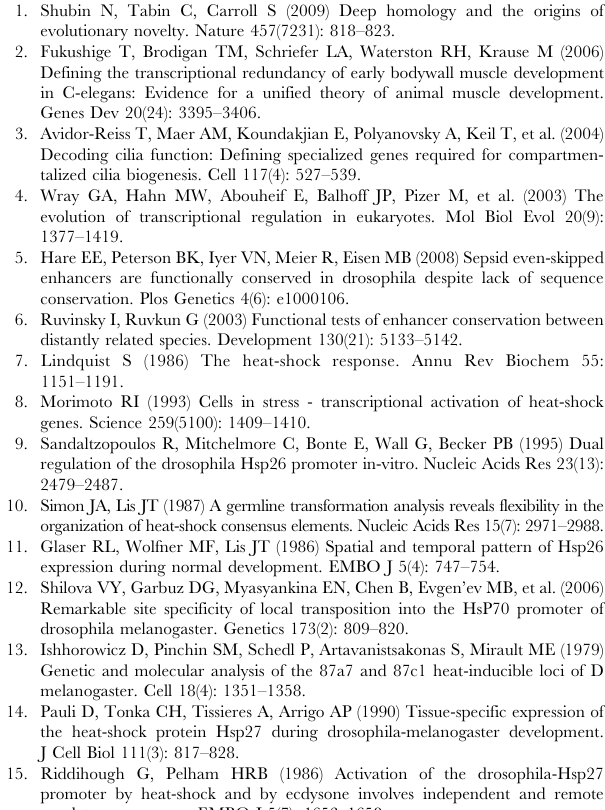
Figure S1 Expression pattern in C. elegans of the Drosophila promoter of housekeeping gene Gapdh2 fused to GFP.